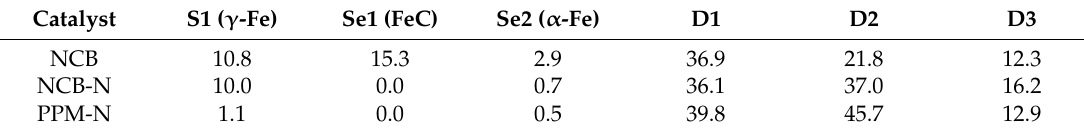
Figure 8. Deconvoluted Mößbauer spectra of ( a ) NCB and ( b ) PPM-N. Table 4. Difference of components of the Fe-N-C electrocatalysts by Mößbauer